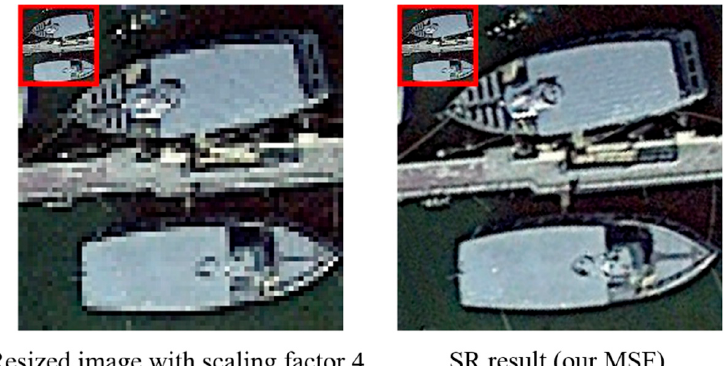
Figure 14. Qualitative comparison between instance-piece from DIOR and SR output of MSF.